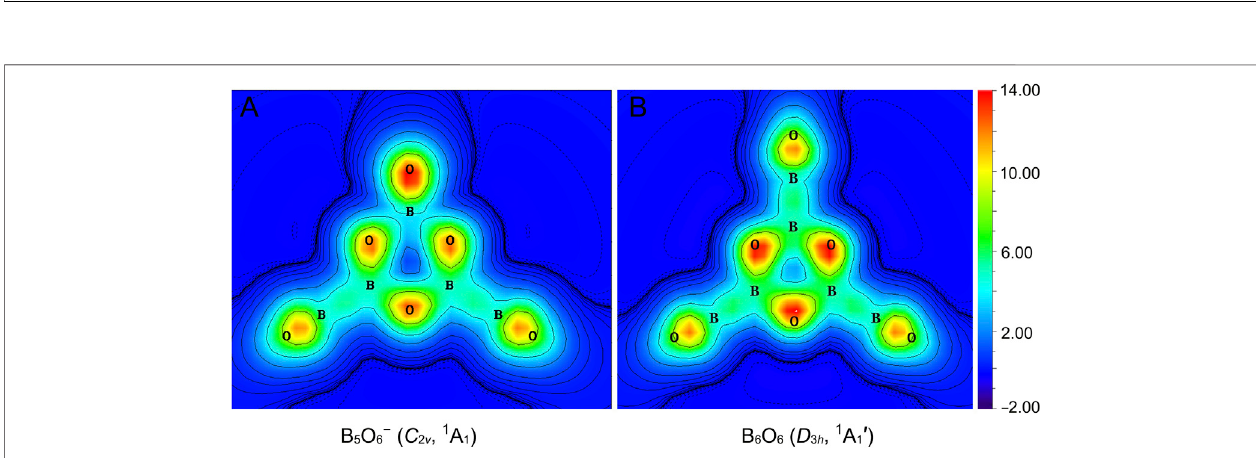
FIGURE 8 | Chemical bonding pattern of B 5 O 6 − (1) cluster according to the adaptive natural density partitioning (AdNDP) analysis. The occupation numbers (ONs) are indicated.